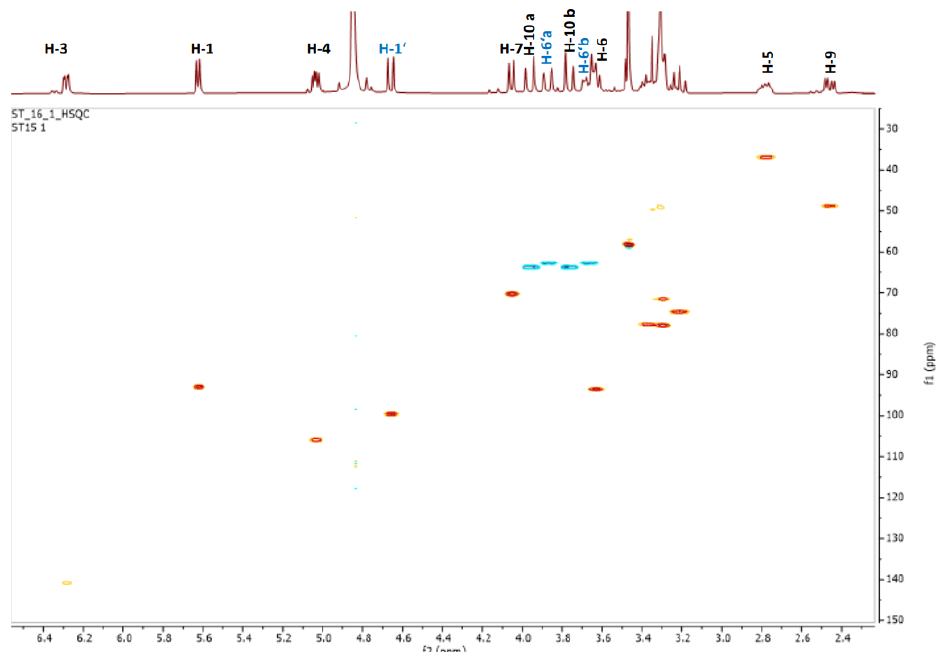
1 H-NMR spectra of compound 5 Figure 4. HSQC and 1 H ‐ NMR spectra of compound 5 . Figure 4. HSQC and